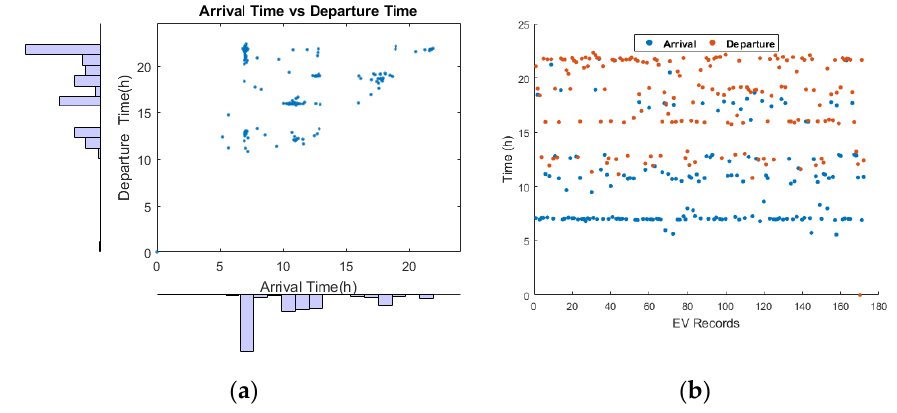
Figure 2. ( a ) EV arrival and departure time distribution and correlation ( b ) Arrival and departure plot.